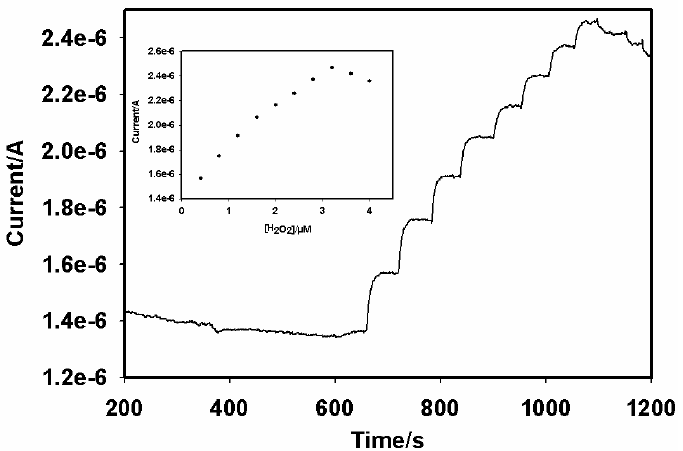
-BSA-conjugate|HRP-blocked) to H 1 O calibration curve obtained from the steady state 2 2